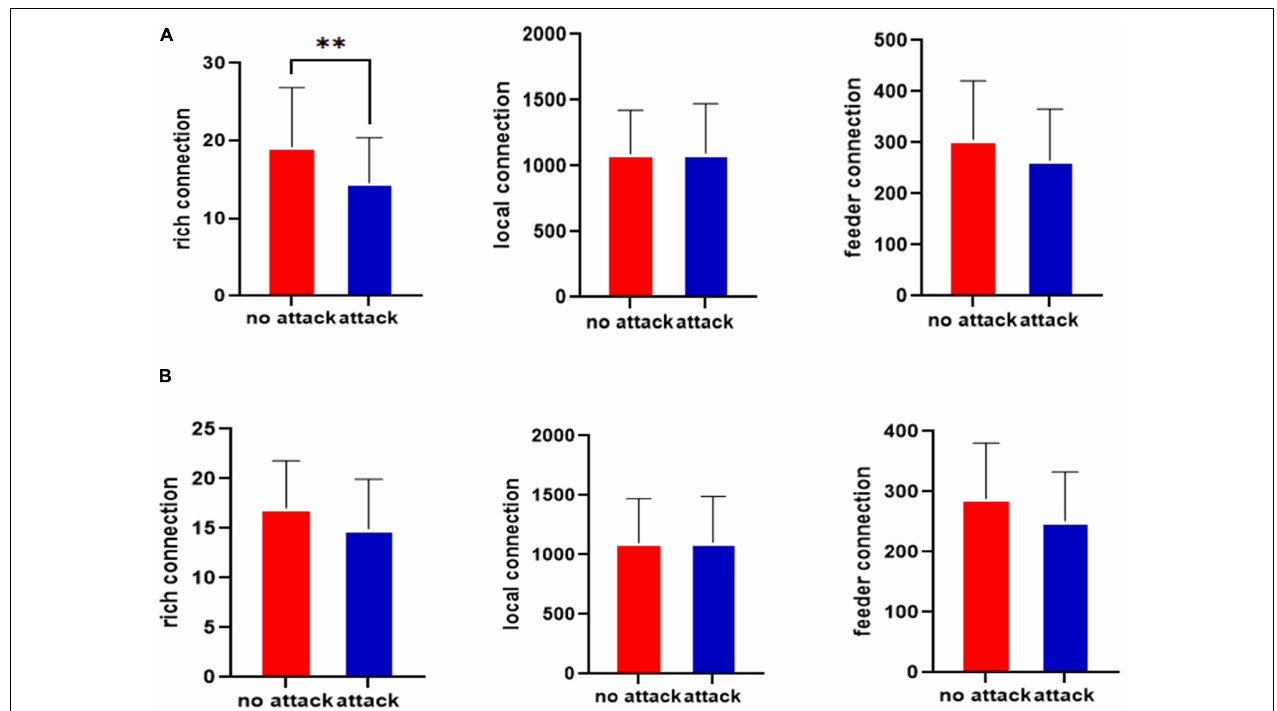
FIGURE 3 | Statistical testing results for the rich-club junction of the left middle cingulate gyrus before and after the attacks in the healthy control group (A) and JME group (B) . ∗∗ p < 0.01,